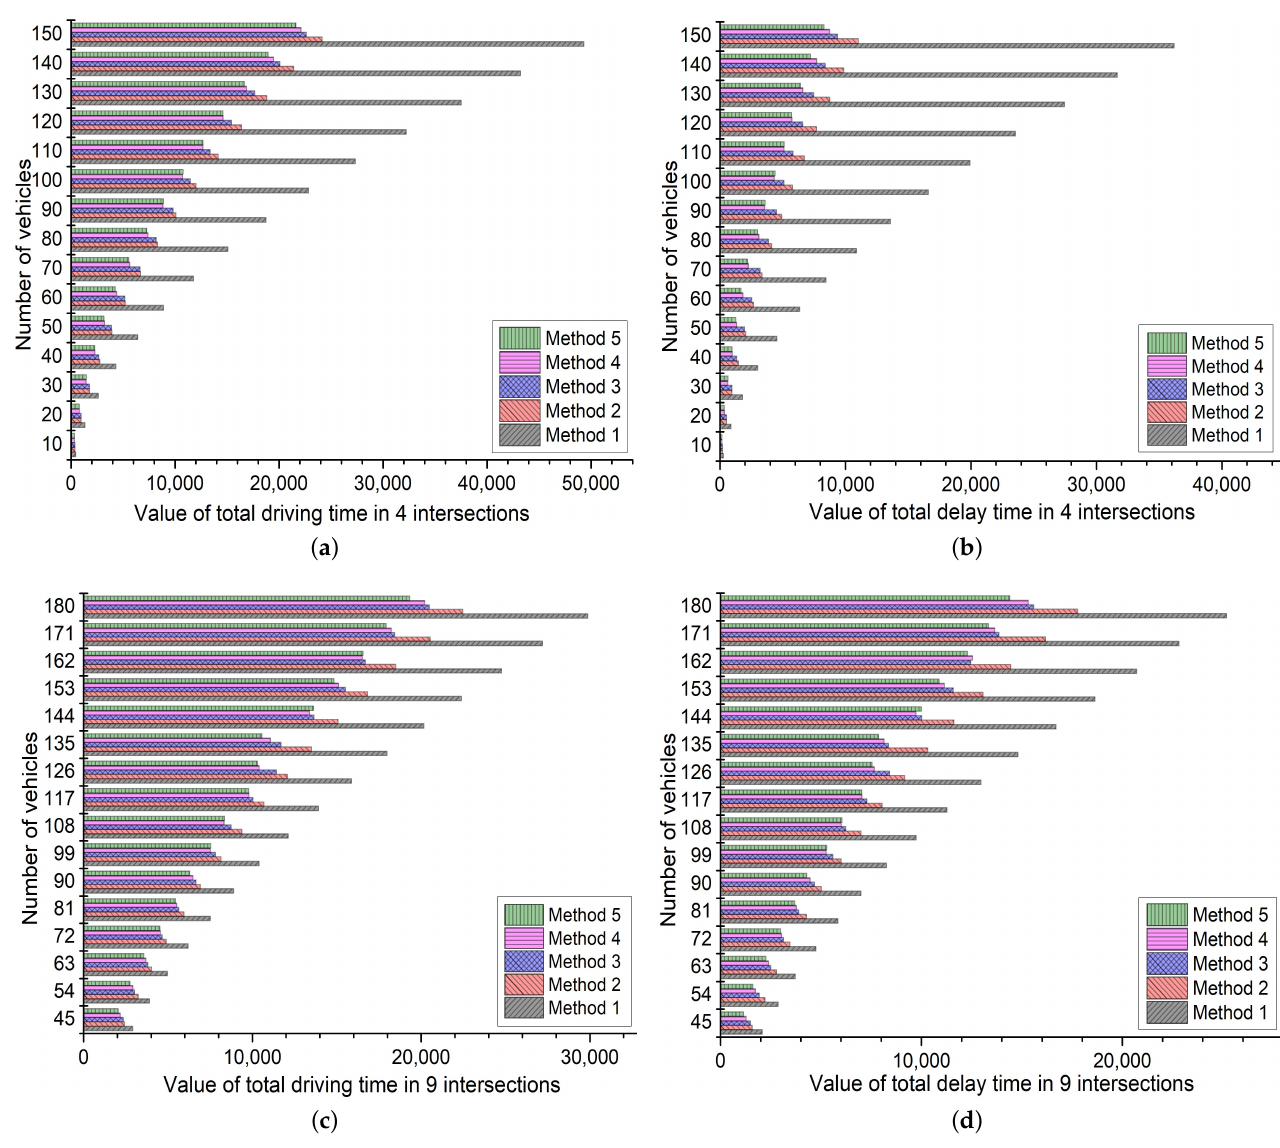
Figure 6. Sensitivity analysis for the results. ( a ) Total driving time of vehicles in 4 intersections, ( b ) Total delay time of signal controllers in 4 intersections, ( c ) Total driving time of vehicles in 9 intersections, ( d ) Total delay time of signal controllers in 9